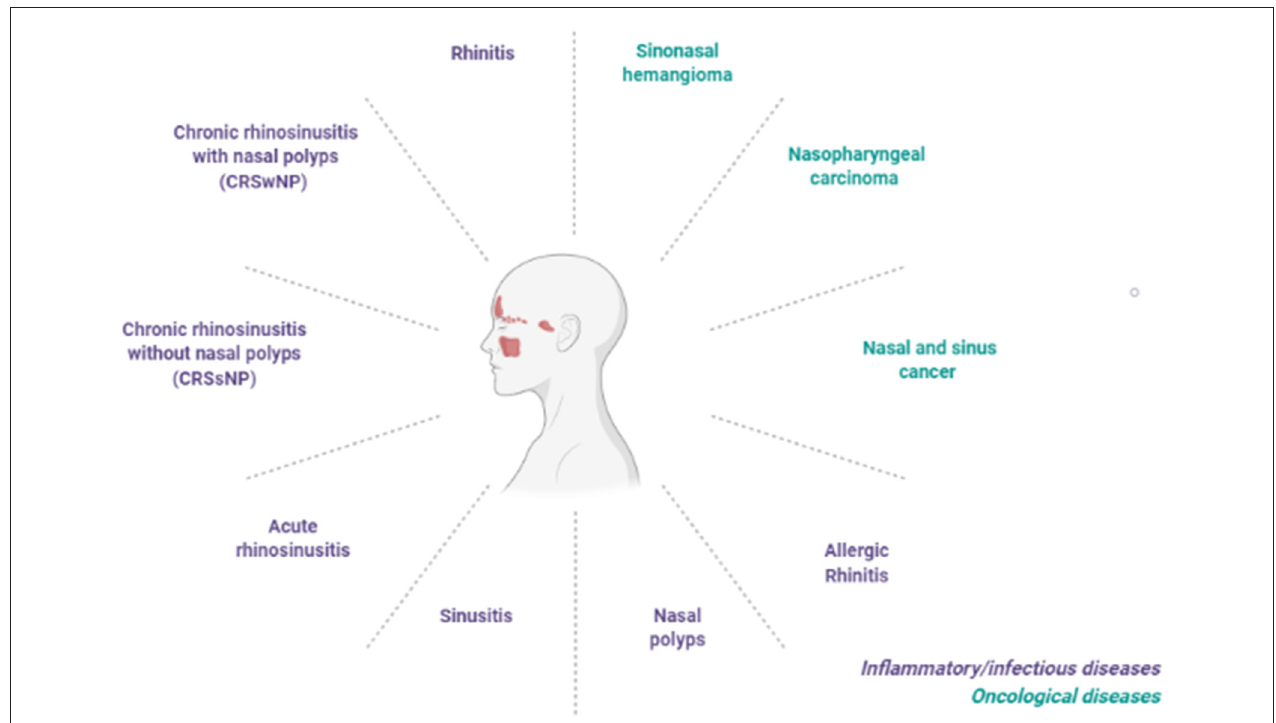
FIGURE 1 | Main inflammatory/infective and oncological conditions affecting the nose and sinus cavities or upper respiratory tract.